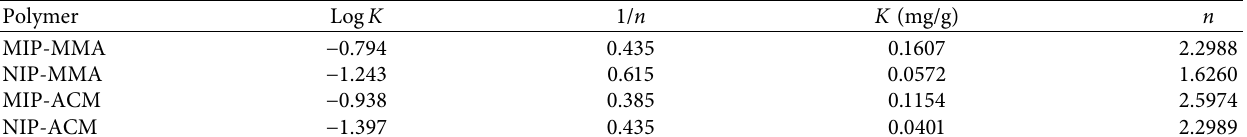
Table 2: Adsorption capacity of the MIP and NIP using the Freundlich isotherm adsorption. Polymer